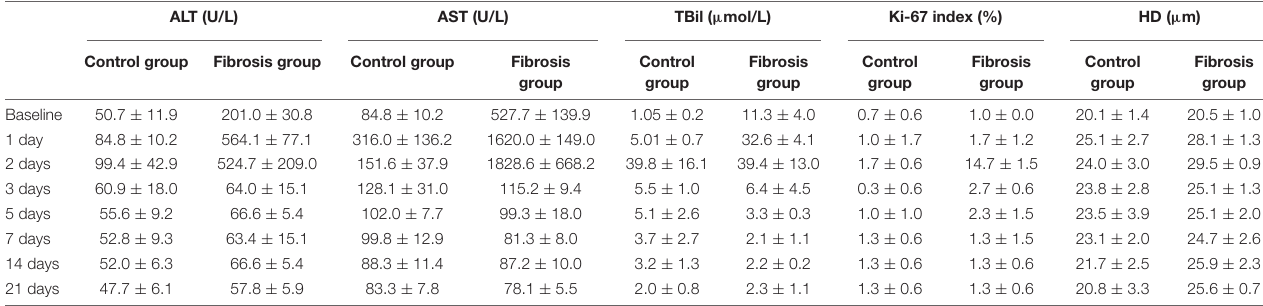
TABLE 2 | Changes in laboratory and histologic findings in control and fibrotic liver tissue groups after left lateral lobe resection.